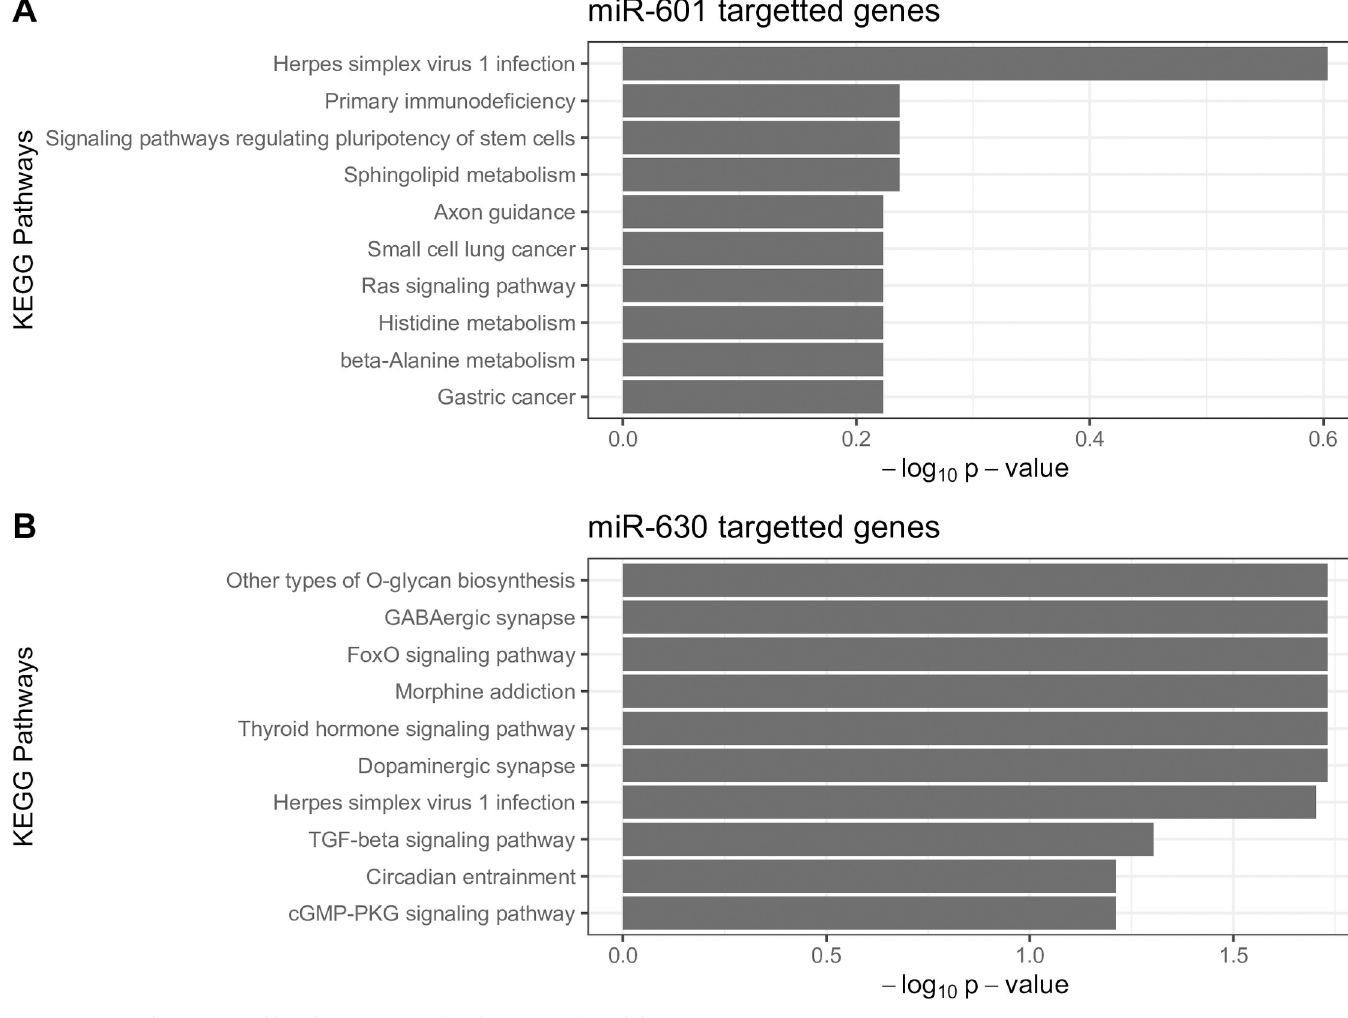
Fig 5. KEGG pathways mapped based on miR-601 (A) and miR-630 (B) candidate target genes.